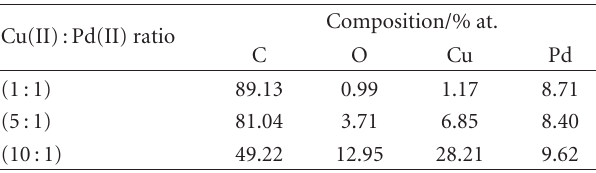
Table 1: Elemental composition (C, O, Cu, and Pd) determined by EDX analysis of the Cu/Pd composites electrodeposited on BDD electrode in solutions with di ff erent Cu(II): Pd(II) ratio. All were deposited applying − 0.3V by